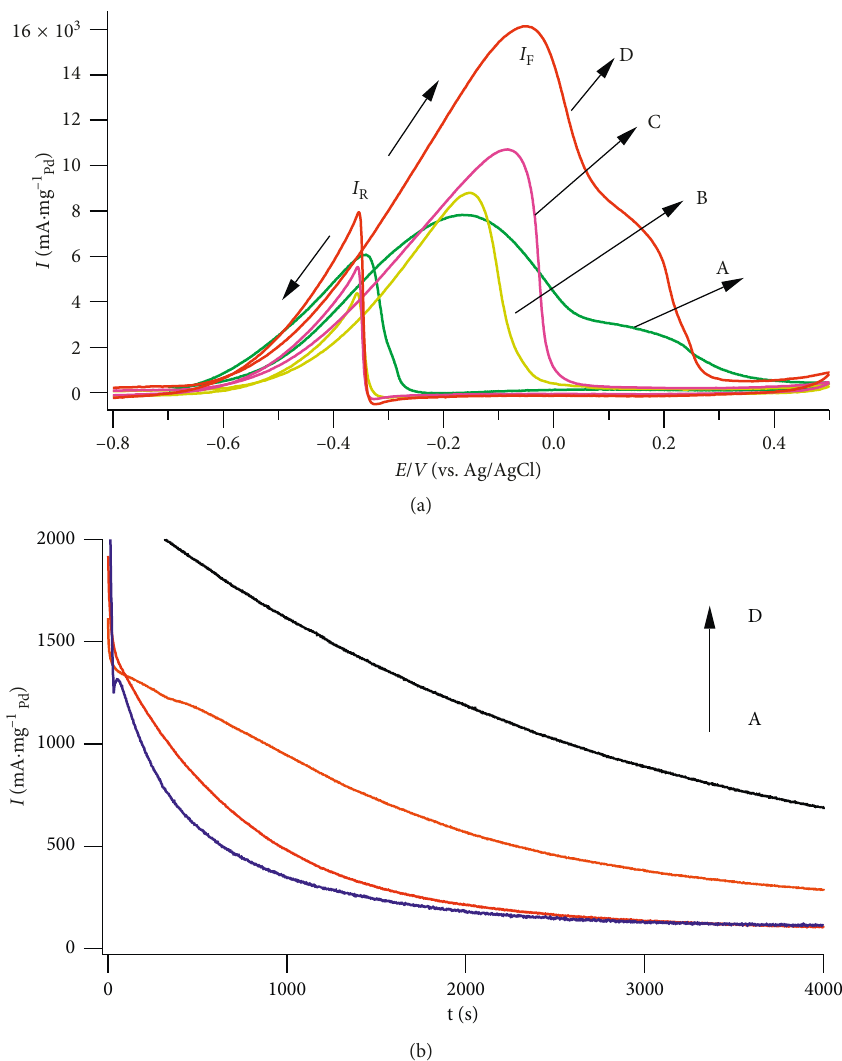
Figure 3: CV (a) and CA (b) curves of (A) PASG.E, (B) PASGN.E, (C) PASG.N, and (D) PASGN.N catalysts in a (NaOH 0.5 M+C 1M) solution at a scan rate of 50mV · s − 1 .